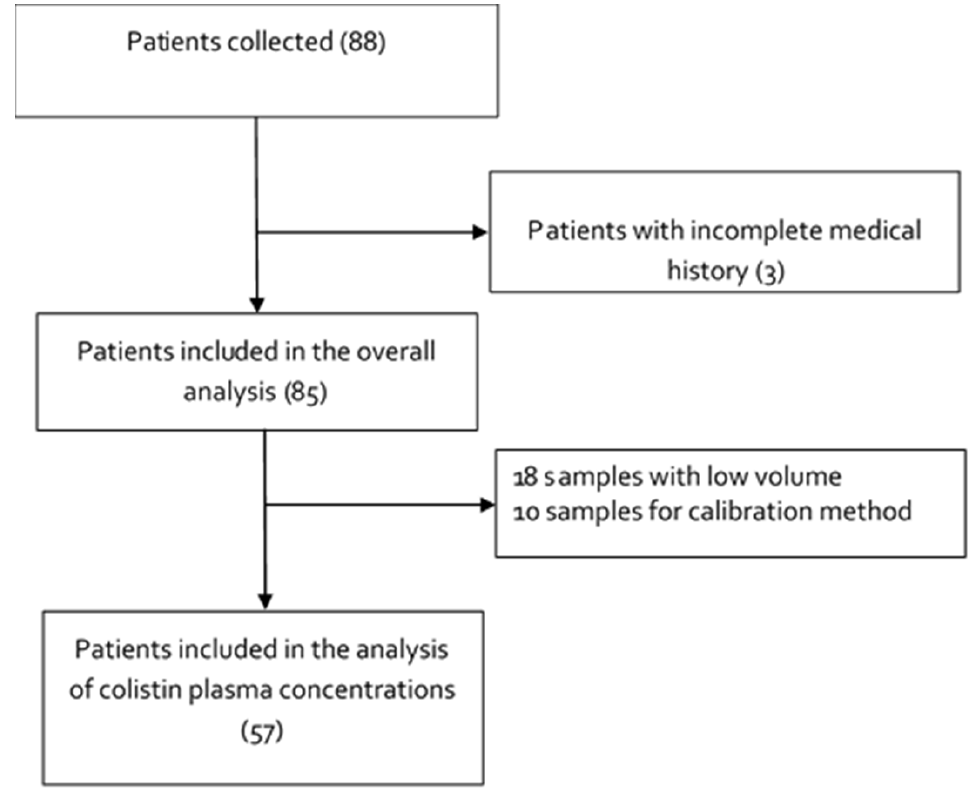
Figure 1. Study flow diagram.